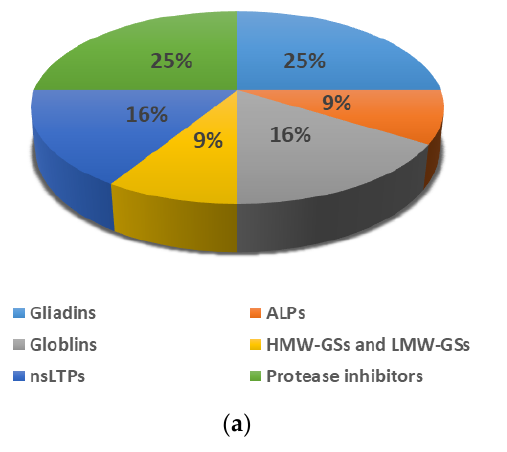
Figure 2. Composition of differentially expressed SSPs and expression patterns of different types of SSPs. ( a ) Composition of differentially expressed SSPs; ( b ) Venn diagram of differentially expressed SSPs at different seed developmental stages.